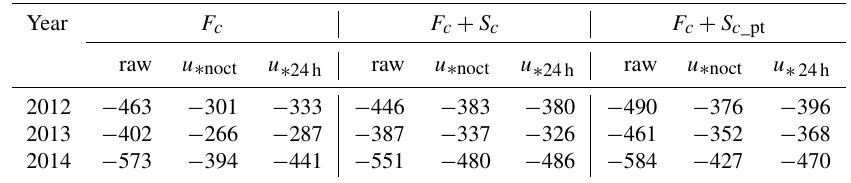
Figure 10. Dependence of corrected storage components and ˆ R e − F c on friction velocity (dashed lines represent corrected storage estimates, stippled region represents difference between measured (blue) and corrected (dashed blue) 0–36m storage, shaded regions represent 95%CI for the u ∗ bin mean). Table 5. Gap-filled annual NEE (gCm − 2 a − 1 ) for 2012–2014 obtained following different data treatment ( F c is turbulent flux only, F c _ u is turbulent flux with low u ∗ conditions removed, F c + S c _pt is summed turbulent flux and point-based storage estimate, ∗ _corr ( F c + S c _pt ) u is summed turbulent flux and point-based storage estimate with low u ∗ conditions removed, F c _ S c is summed tur- ∗ _corr bulent flux and profile-based storage estimate, ( F c + S c ) u is summed turbulent flux and profile-based storage estimate with low u ∗ ∗ _corr conditions